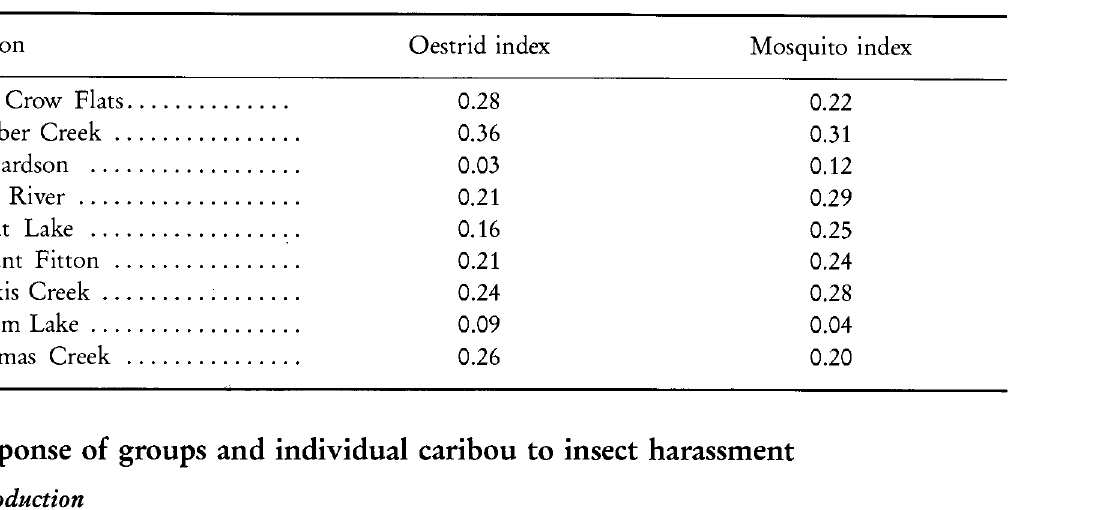
Table 4.4. Mean daily oestrid fly and mosquito harassment indices for the temporary weather stations on the summer range of the Porcupine Caribou Herd, July